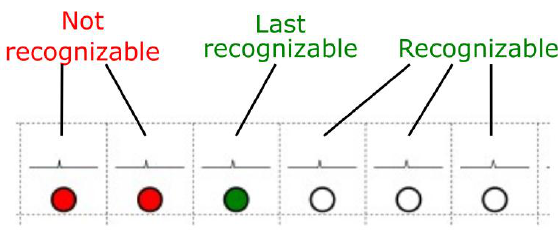
Figure 7. Fragment of a row with cells marked as recognisable and unrecognisable.